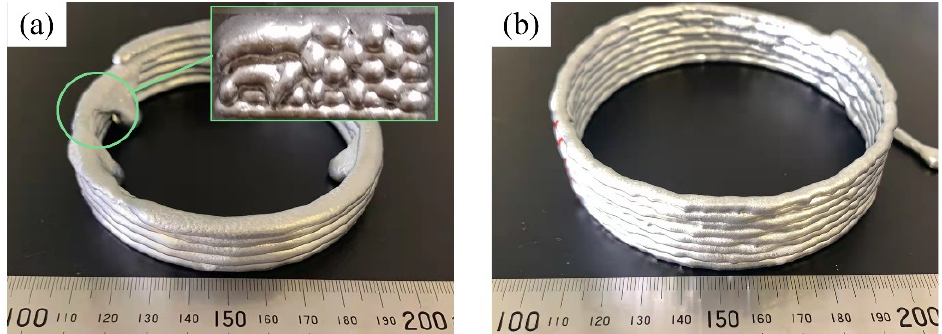
Figure 14. Semi-solid melt direct-writing specimens with different liquid phase volume fractions, ( a ) liquid melting direct writing; ( b ) 35~45% liquid volume fraction semi-solid melt direct